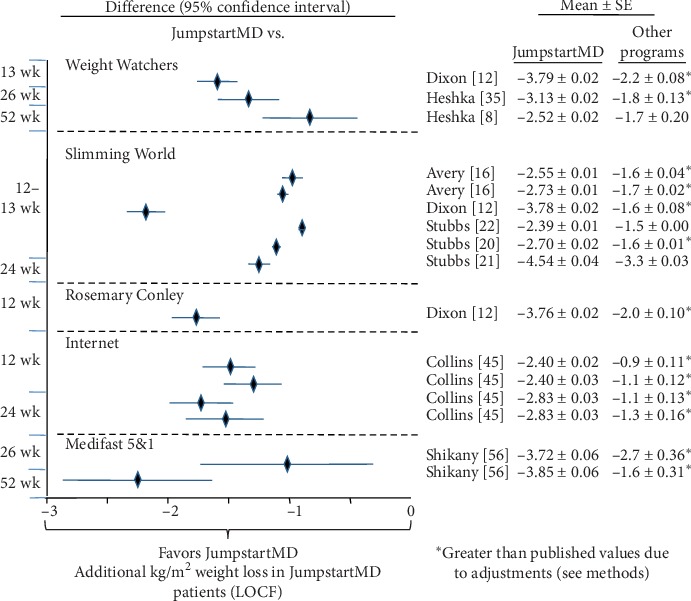
Mean LOCF weight loss difference between JumpstartMD and other commercial programs as measured by ΔBMI. Negative differences designate greater JumpstartMD BMI loss. See legend to Figure 5 for further explanation.